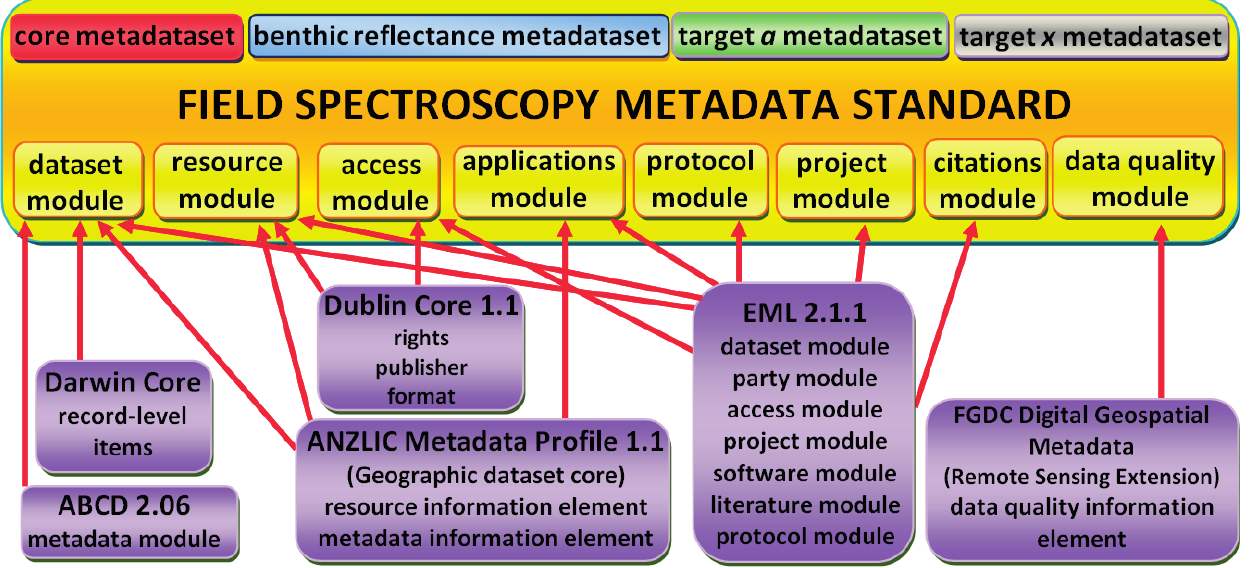
Figure 6. A proposed hybrid metadata standard fusing the core and application-specific field spectroscopy metadatasets with elements from the standards